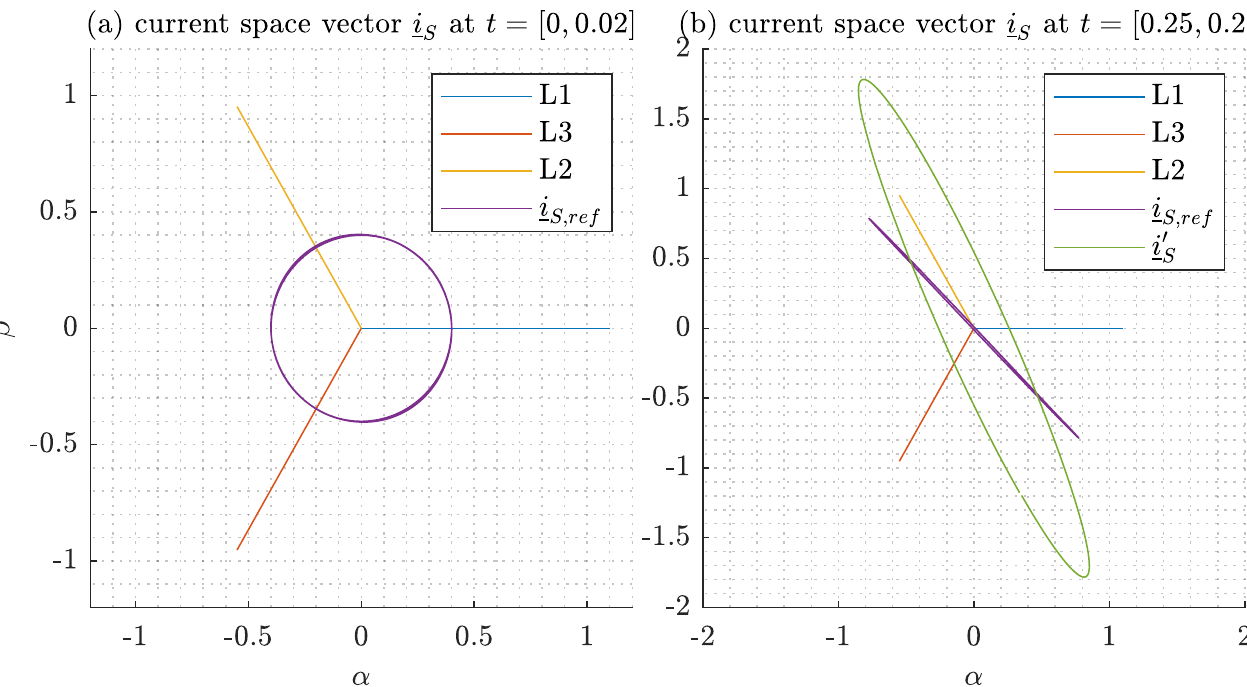
Figure 7. Vector diagrams of the space vectors in the αβ -plane before ( a ) and during ( b ) the short-circuit event. In ( a ) and ( b ) the vectors L1, L2 and L3 all have a length of i max . ( b ) shows that during the short-circuit event the projection of i S , ref on L3 equals the maximum current capability i max